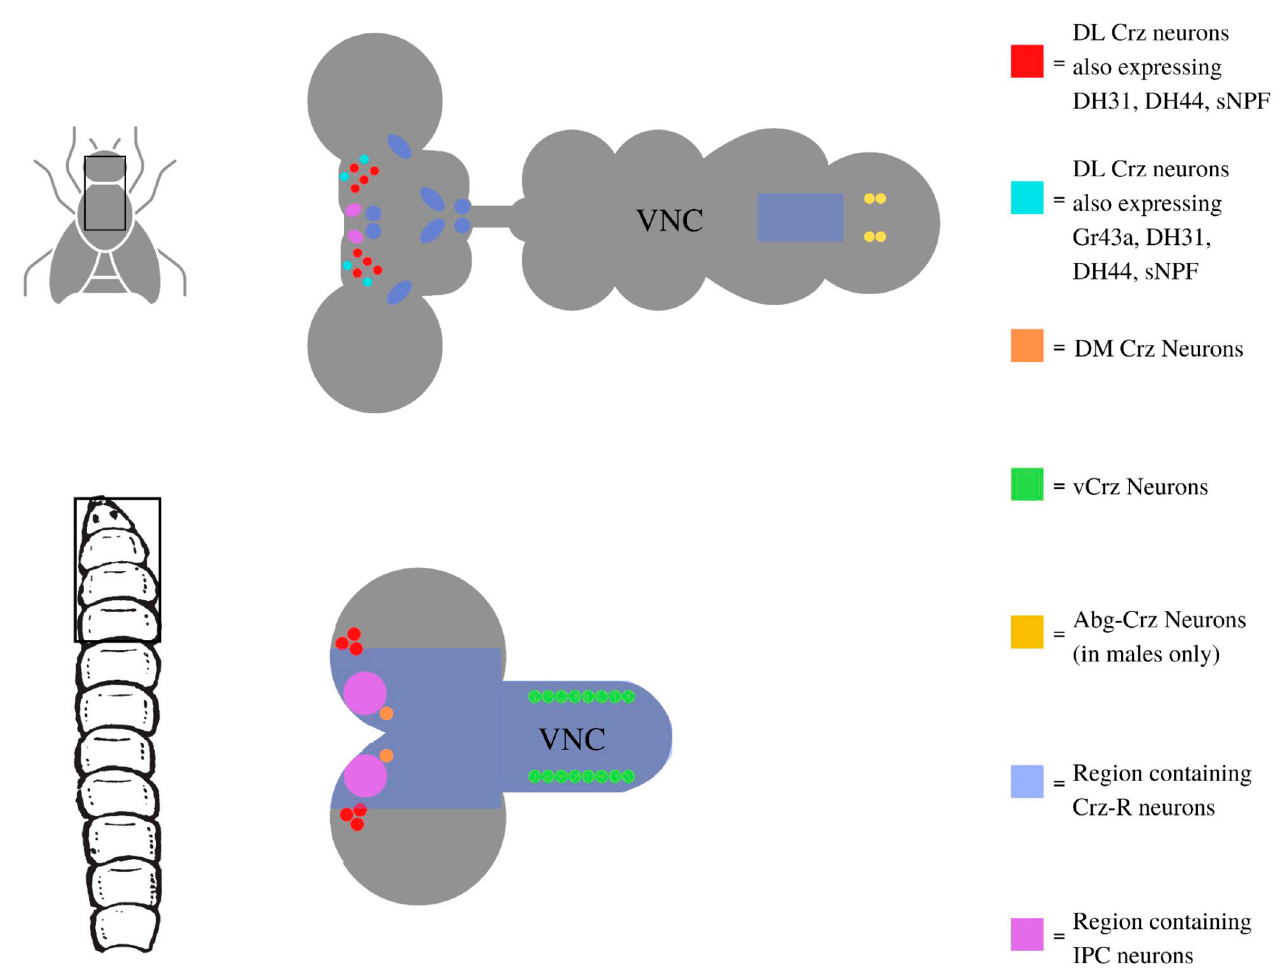
Figure 1. Diagram showing the populations of Corazonin (Crz) expressing neurons in the nervous systems of third-instar larvae and adult flies. In third-instar larvae, one dorsomedial (DM) neuron and three dorsolateral (DL) neurons are present in either hemisphere of the brain, and eight pairs of neurons (vCrz) are present on either side of the ventral nerve cord. DH31-R1 and DH44-R1 expression is present in all of these cells, while sNPF is only present in the DM and DL neurons, but not the vCrz neurons [21]. In adults, 6–8 dorso-latero-posterior (DLP) neurons are present on either hemisphere of the brain, and 4–6 Abg-Crz neurons are present in the abdominal ganglion in males only. DH31-R1, sNPF, and DH44-R1 expression is present in the DLP cells but not the AbgCrz neurons. Cells that also express Gr43a are indicated in cyan, however it should be noted that the number and locations of these cells vary. General regions in the adult and larval nervous system that contain Crz receptors (CrzR) are indicated in blue, while regions containing IPC neurons are indicated in magenta. The specific locations of additional neurons in the fly neurosecretory system (such as sNFP or IPCs) has been recently reviewed [11]. Relative locations of larval CrzR neurons are based on [15,16]. It is worth mentioning that different observations have been reported for CrzR expression in the adult brain. Whereas Zer-Krispil et al. (2018) [8] reported CrzR expression in numerous fat cells that surround the brain, a recent study by Zandawala et al. (2021) [17] showed expression of CrzR in brain neurons.